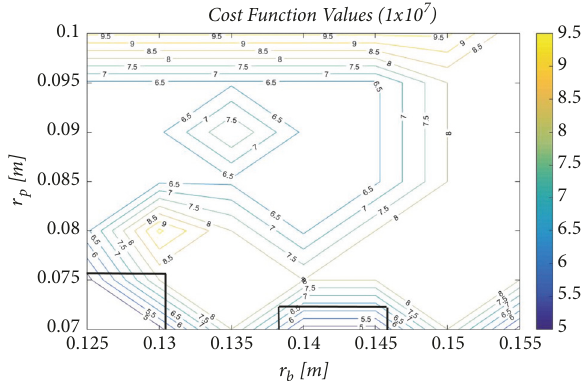
Figure 7: Two-variable ( 𝑟 𝑝 , 𝑟 𝑏 ) optimization